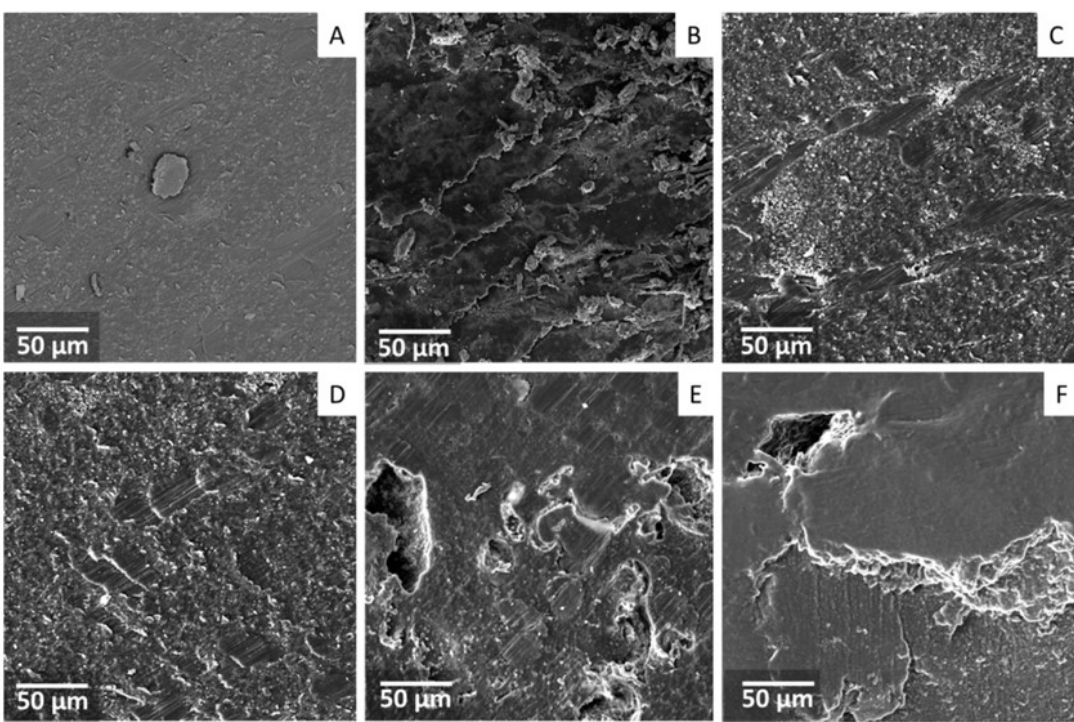
(C) EDPM 2 tested under 0.45 MW/m 2 ,